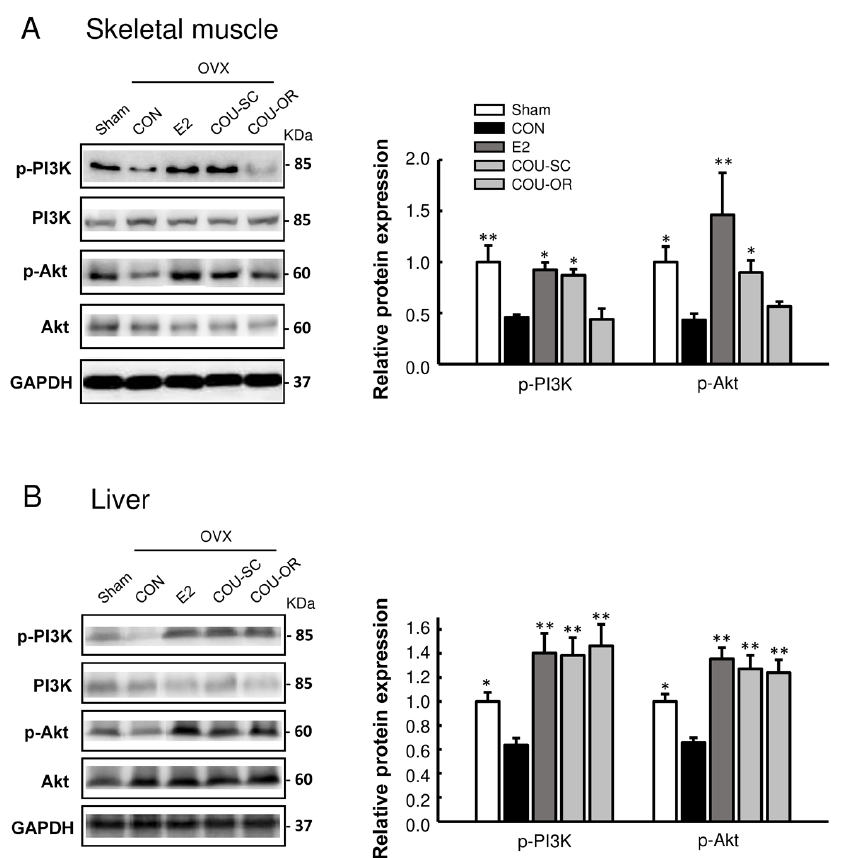
Figure 5. Regulatory effects of coumestrol on insulin signaling in OVX mice. Western blotting of ( A ) phosphorylated phosphoinositide 3-kinase (p-PI3K), total PI3K, phosphorylated protein kinase B (p-Akt), and total Akt in skeletal muscle and ( B ) liver with quantitative data. Values represent means ± SEM ( n = 4). CON, control; E2, 17 β -estradiol; COU-SC, coumestrol subcutaneous treatment; COU-OR, coumestrol oral treatment; OVX, ovariectomized; GAPDH, glyceraldehyde-3-phosphate dehydrogenase; KDa, kilodaltons. *Significantly different from the OVX control group (* p < 0.05, ** p < 0.01).